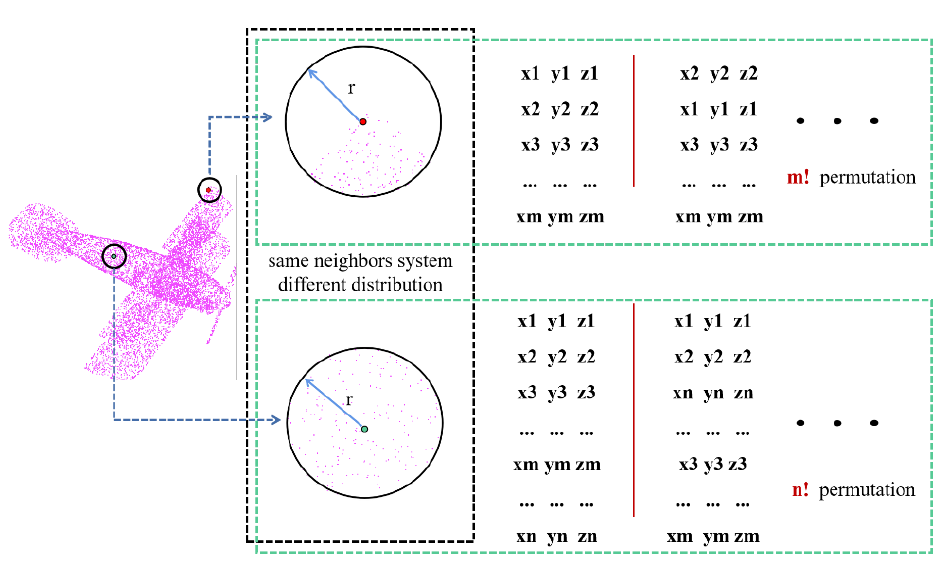
Figure 3. The irregularity and disorder of a 3D point cloud: The point cloud is shown on the left. The middle black dashed box shows the irregularity of the 3D point cloud with the same neighbor radius r, different numbers of points (m and n), and different distributions. The green dashed boxes on the right both show the disorder of the 3D point cloud, where the same point cloud has n! different orders, although they express the same entity.